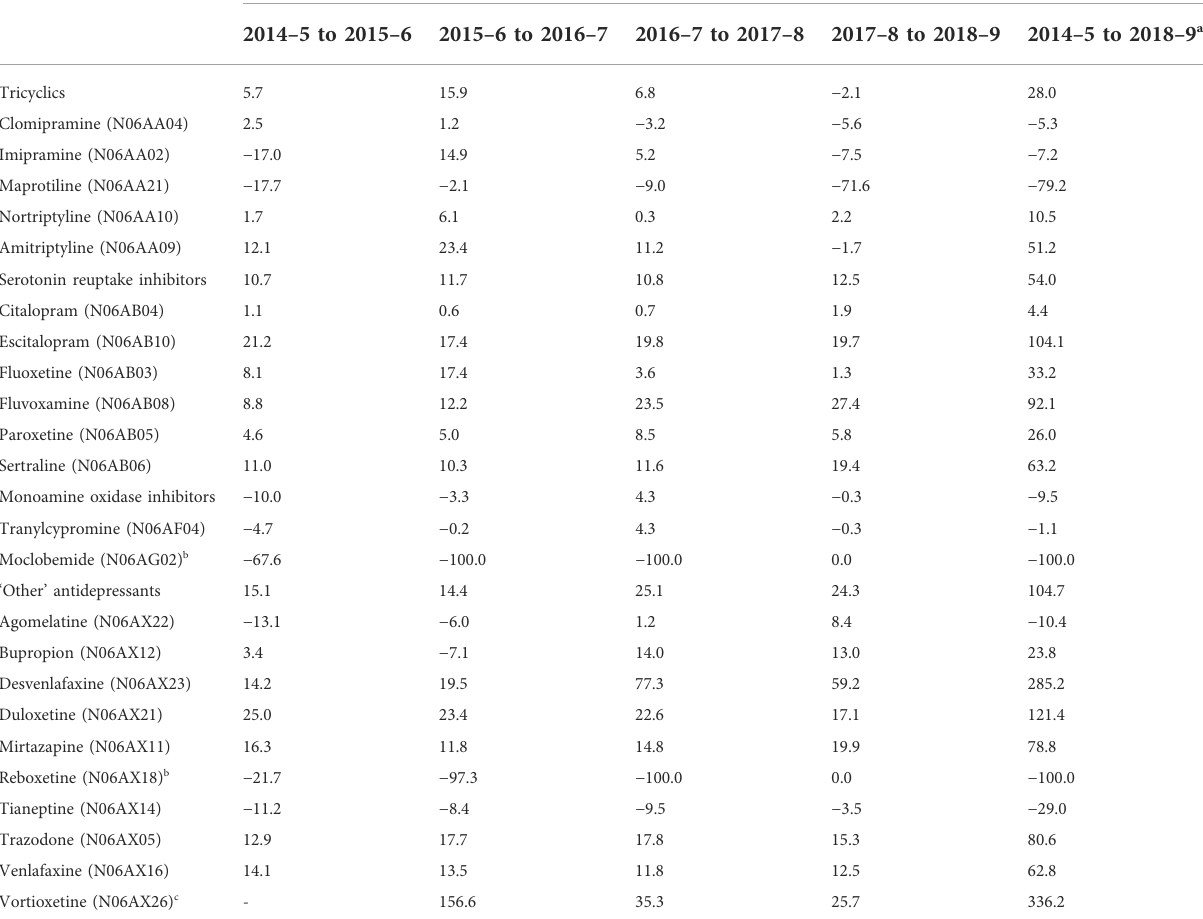
TABLE 2 Sale growth rate of antidepressants in Brazil, from November 2014 to October